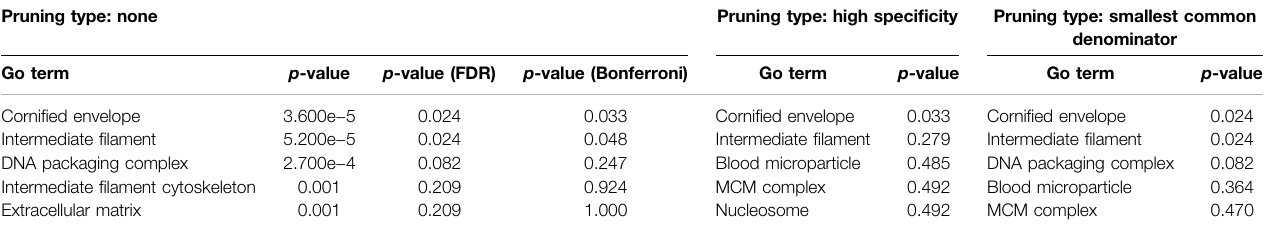
TABLE 5 | Top identi fi ed cellular components for each pruning